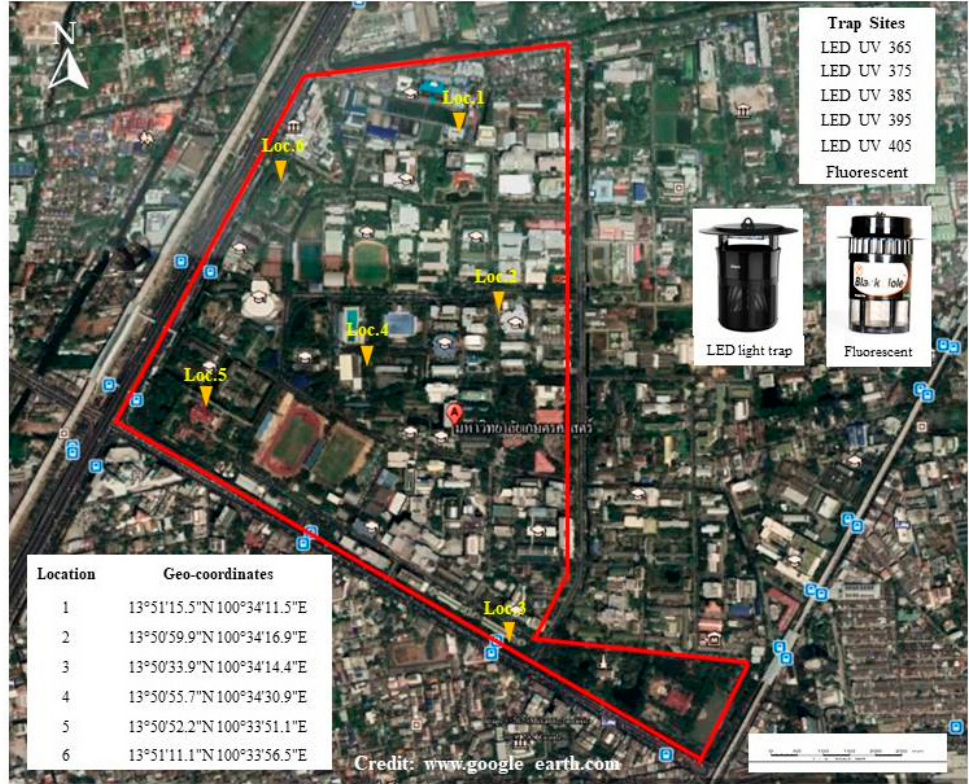
Figure 1. Locations for setting light traps (18:00 to 06:00 h) to capture adult mosquitoes at Kasetsart University, Bangkok, Thailand.